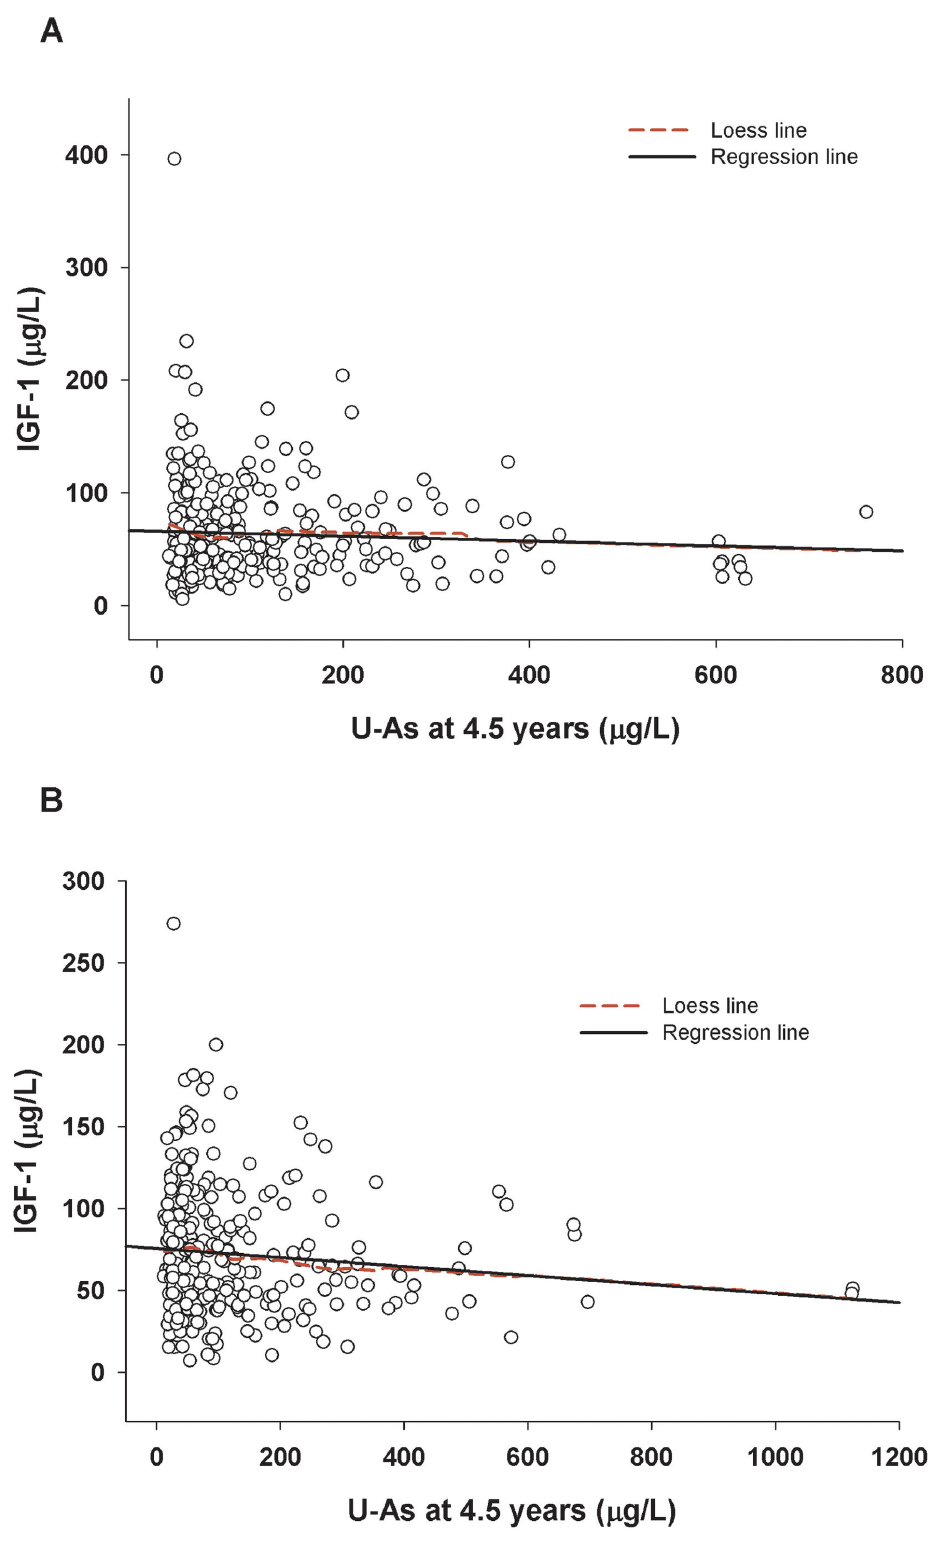
Figure 2. Associations between concurrent urinary arsenic (U-As) and plasma IGF-1 in 4.5 years children; (A) boys (r =-0.06; P=0.26), (B) girls (r =-0.118; P=0.038). Solid line indicates linear regression line and dashed line indicates Loess line. s s doi: 10.1371/journal.pone.0081530.g002 PLOS ONE |